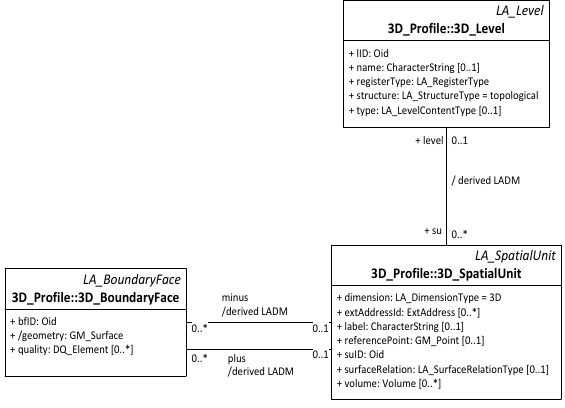
Figure 2. 3D topology based on LADM (after ISO 19152: 2012) All topological boundary faces are used once in plus and also exactly once in minus direction. Unless the boundary face is on the edge of the domain, then either the plus or the minus direction is used once (and the other zero times). The boundary faces do not self-intersect and do meet other boundary faces at their boundaries. All 3D_BoundaryFaces have outward orientation (normal vector points to the outside). All the 3D_BoundaryFaces together form at least one outer shell and zero or more inner shells. In principle, the shells are closed, with the exception that they may open (unbound) to the top (sky) and bottom (earth)